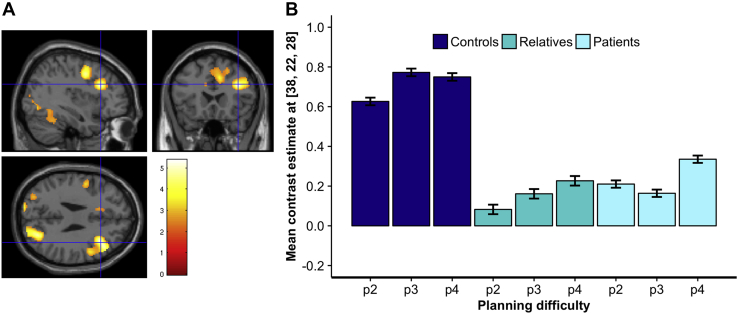
Brain areas of hypoactivation in patients with obsessive-compulsive disorder and their first-degree unaffected relatives during goal-directed planning. (A) At all levels of planning complexity, patients with obsessive-compulsive disorder and their first-degree relatives showed hypoactivation in an extensive cluster in the right middle frontal gyrus, including Brodmann areas 6, 9, and 9/46. Brain activation rendered at p < .01 corrected for false discovery rate, with 4592 voxels extent threshold for display purposes. (B) Parameter estimate in arbitrary units in the dorsolateral prefrontal cortex at peak coordinates x = 38, y = 22, z = 28 (significant at p < .05; familywise error, corrected for the whole-brain mass). Error bars denote SEM. p2, planning 2 moves; p3, planning 3 moves; p4, planning 4 moves.